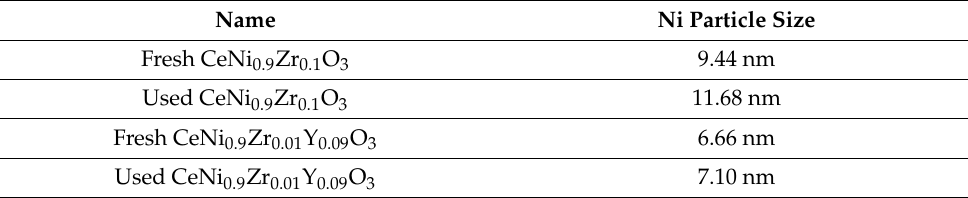
Figure 4. XRD pattern of perovskite catalyst CeNi 0.9 Zr 0 . 1 − x Y x O 3 (x = 0.03 and 0.05).